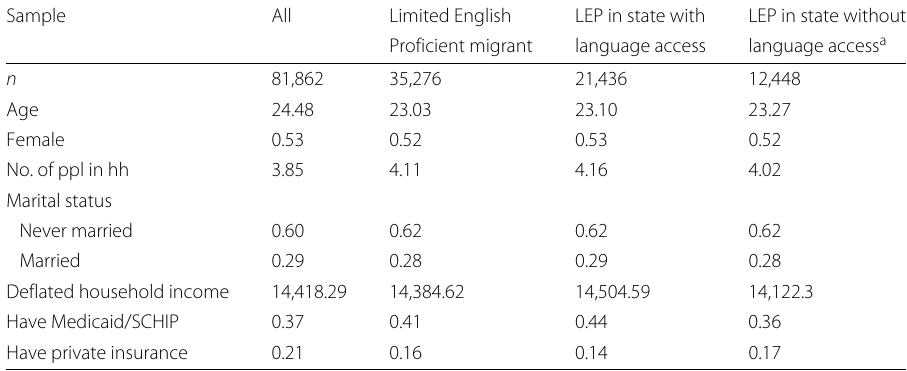
Table 2 Summary statistics of individuals with deflated household income of less than $25,000 (2008 base